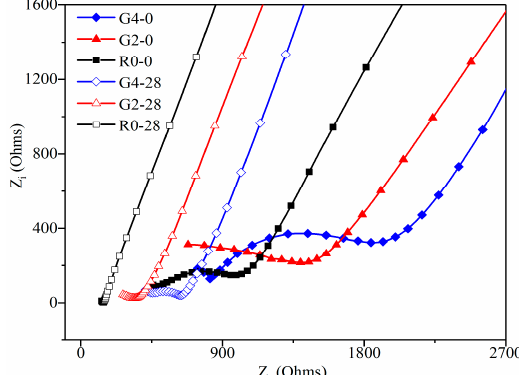
Figure 11. The Nyquist curves of R0, G2, and G4 before leaching and after leaching for 28 days.